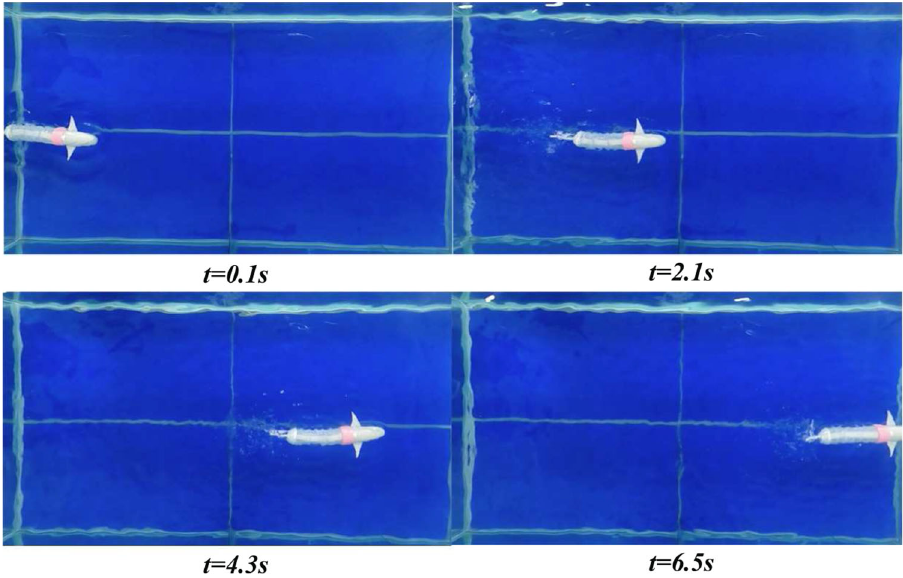
Fig. 13 The actual swimming experiment of biomimetic robotic fish using CPG model based on MOWOA optimization